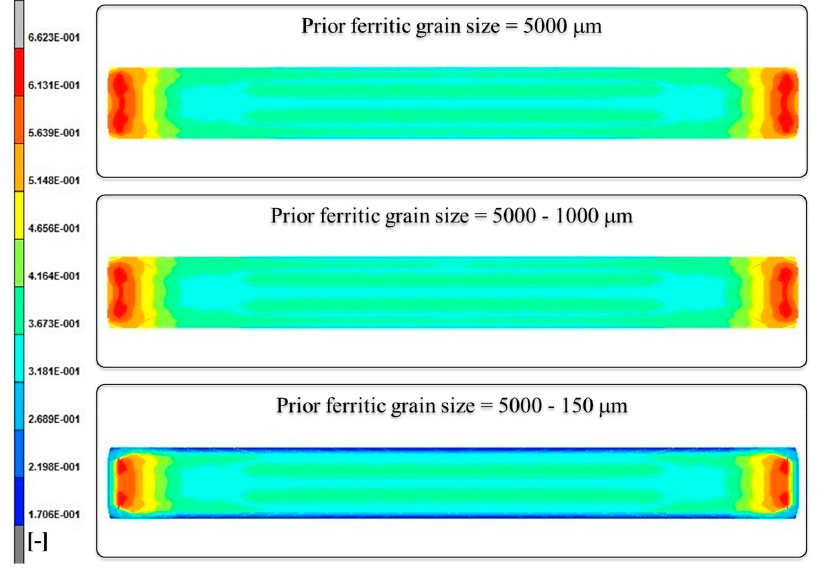
Figure 13. Effect of PFGS on damage after the fifth roughing pass.